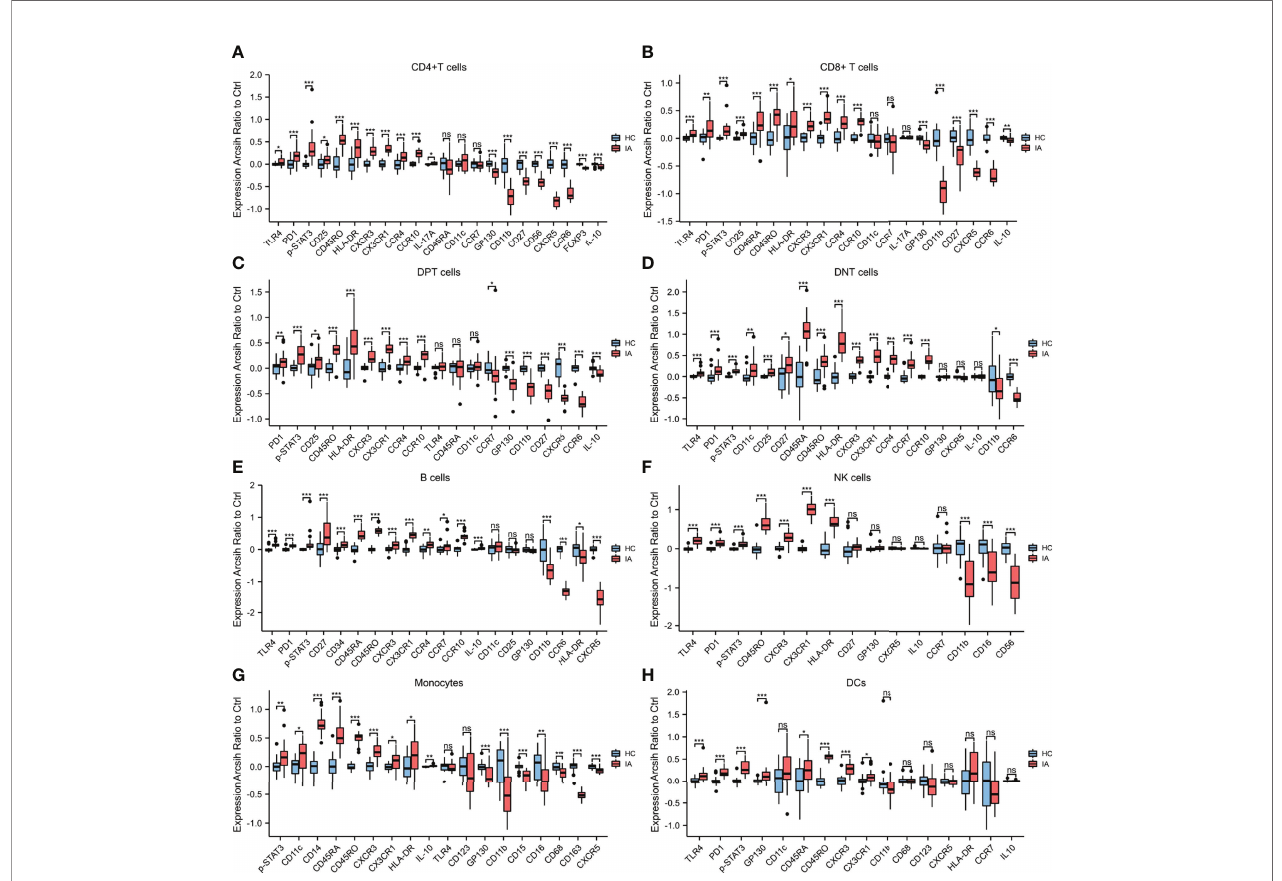
FIGURE 3 | Marker expressions in 8 cell lineages. (A) Marker expressions in CD4+ T cells from HC and IA patients. The expression levels of TLR4, PD1, p-STAT3, CD25, CD45RO, HLA-DR, CXCR3, CX3CR1, CCR4, CCR10, and IL-17A in CD4+ T cells were higher in the IA group than in the HC group. The levels of GP130, CD11b, CD27, CD56, CXCR5, CCR6, FOXP3, and IL-10 were lower in the patient groups than in the HC group. (B) Marker expressions in CD8+ T cells from HC and IA patients. The expression levels of TLR4, PD1, p-STAT3, CD25, CD45RA, CD45RO, HLA-DR, CXCR3, CX3CR1, CCR4, and CCR10 in CD8+ T cells were higher in the IA group than in the HC group. However, the expression levels of GP130, CD11b, CD27, CXCR5, CCR6, and IL-10 were lower in the IA group than in the HC group. (C) Marker expressions in DPT cells from HC and IA patients. The expression of PD1, p-STAT3, CD25, CD45RO, HLA-DR, CXCR3, CX3CR1, CCR4, and CCR10 in DPT cells was higher in the IA group than in the HC group. The levels of GP130, CD11b, CD27, CXCR5, CCR6, and IL-10 were lower in the patient groups than in the HC group (D) Marker expressions in DNT cells from HC and IA patients. The expression levels of TLR4, PD1, p-STAT3, CD11c, CD25, CD27, CD45RA, CD45RO, HLA-DR, CXCR3, CX3CR1, CCR4, CCR7, and CCR10 in DNT cells were higher in the IA group than in the HC group. In addition, the levels of CD11b and CCR6 were lower in the patient groups than in the HC group. (E) Marker expressions in B cells from HC and IA patients. The expression levels of TLR4, PD1, p-STAT3, CD27, CD34, CD45RA, CD45RO, CXCR3, CX3CR1, CCR4, CCR7, CCR10, and IL-10 in B cells were higher in the IA group than in the HC group. The levels of CD11b, CCR6, HLA-DR, and CXCR5 were lower in the patient groups than in the HC group. (F) Marker expressions in NK cells from HC and IA patients. The expression levels of TLR4, PD1, p-STAT3, CD45RO, CXCR3, CX3CR1, and HLA-DR in NK cells were higher in the IA group than in the HC group. The levels of CD11b, CD16, and CD56 were lower in the IA group than in the HC group. (G) Marker expressions in monocytes from HC and IA patients. The expression levels of p-STAT3, CD11c, CD14, CD45RA, CD45RO, CXCR3, CX3CR1, and HLA-DR in monocytes were higher in the IA group than in the HC group. However, the levels of GP130, CD11b, CD15, CD16, CD68, CD163, and CXCR5 were lower in the IA group than in the HC group. (H) Marker expressions in DCs from HC and IA patients. The expression levels of TLR4, PD1, p-STAT3, GP130, CD11c, CD45RA, CD45RO, CXCR3, and CX3CR1 in DC cells were higher in the IA group than in the HC group. P values were calculated by the two-sided Wilcoxon test. Signi fi cance: ***p < 0.001; **p < 0.01; *p < 0.05; ns p ≥